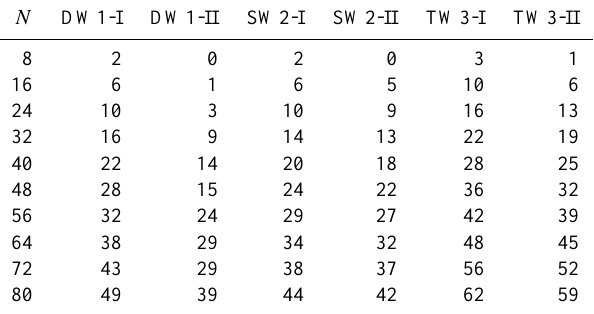
Table 1. Number of good eigenvalues of three tidal waves: DW1, SW2 and TW3, computed with different truncation N using two different methods: I – normalized ALP expansion, II – Chebyshev